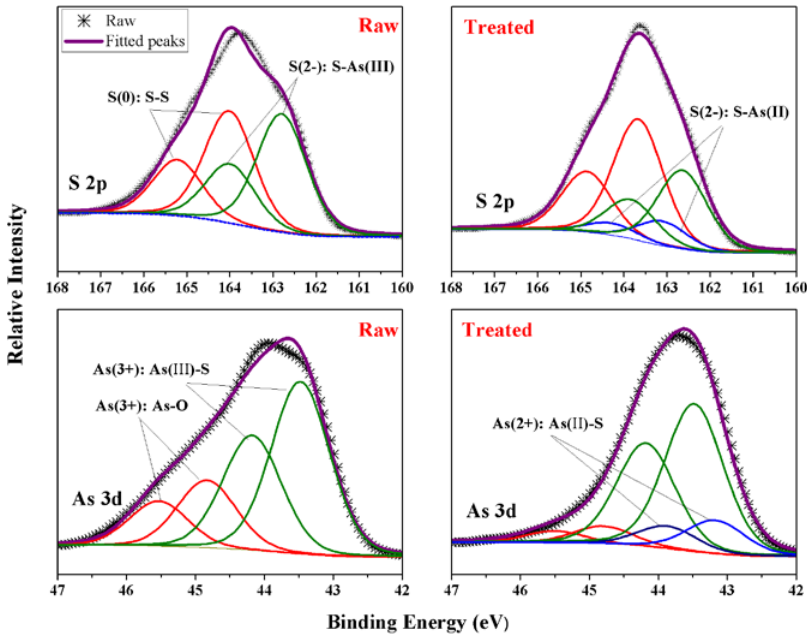
Figure 7. XPS spectra of S 2p and As 3d peaks for the raw HB-ASR and that treated for 240 min using a low pass energy of 30 eV.